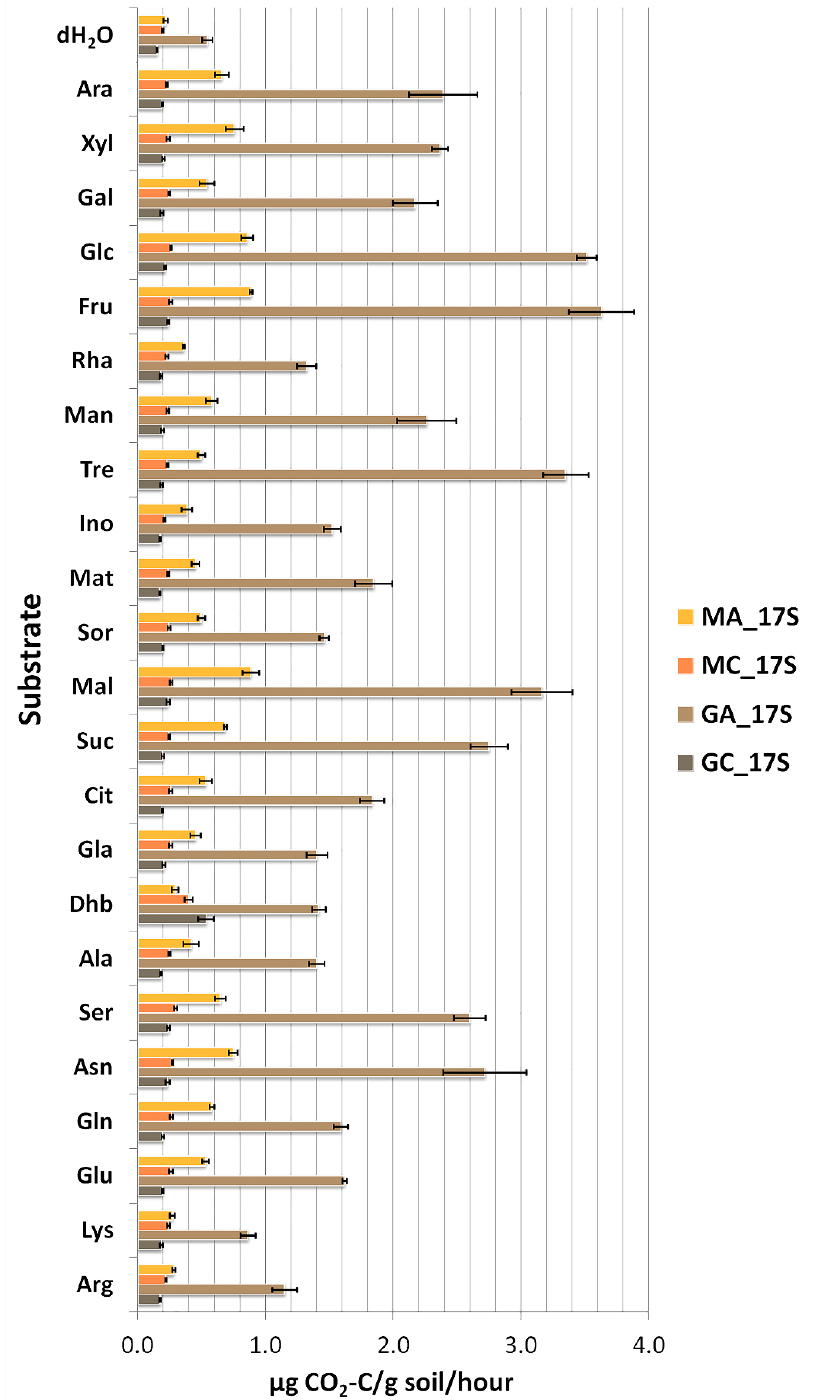
Figure 1. The metabolic potential of the maize monoculture and grassland samples measured in the MicroResp™ system with 23 substrates (μg CO2-C/g soil/hour). dH 2 O: distilled water; Ara: arabinose; Xyl: xylose; Gal: galactose; Glc: glucose; Fru: fructose; Rha: rhamnose; Man: mannose; Tre: trehalose; Ino: inositol; Mat: mannitol; Sor: sorbitol, Mal: malate; Suc: succinate; Cit: citrate; Gla: gluconate; Dhb: dihydroxy-benzoate; Ala: alanine; Ser: serine; Asn: asparagine; Gln: glutamine; Glu: glutamate; Lys: lysine; Arg: arginine. (For sample designations see Table 1.)